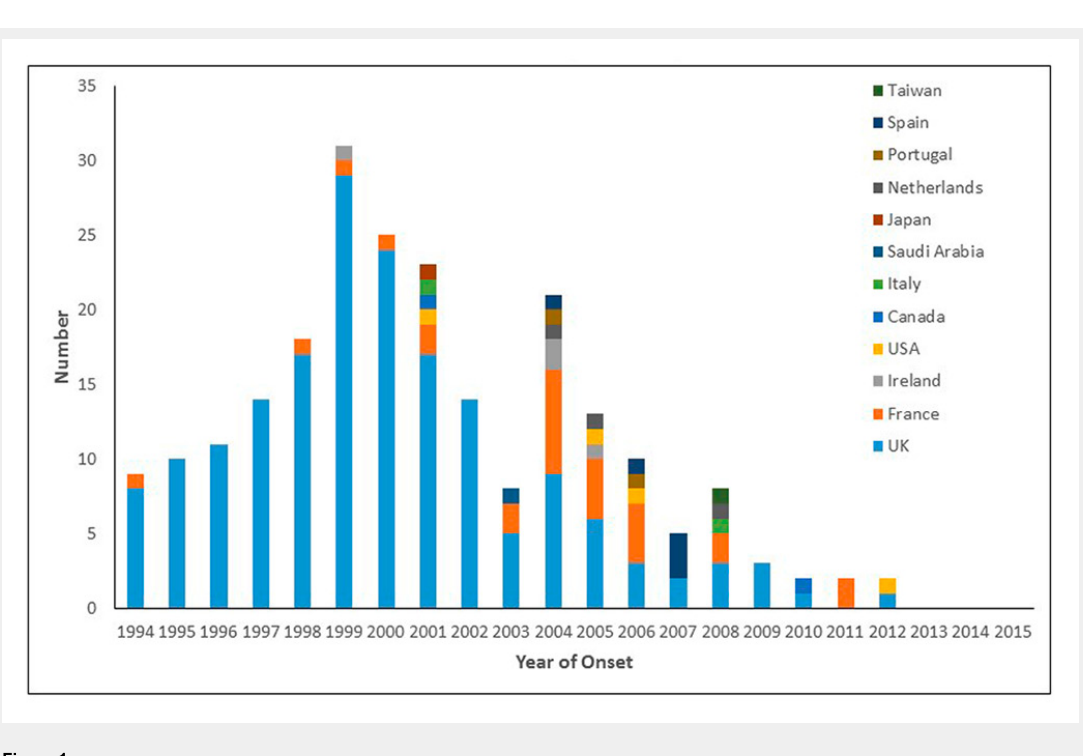
Figure 1 Variant Creutzfeldt Jakob disease cases by year and country: 1994-2015 (n =